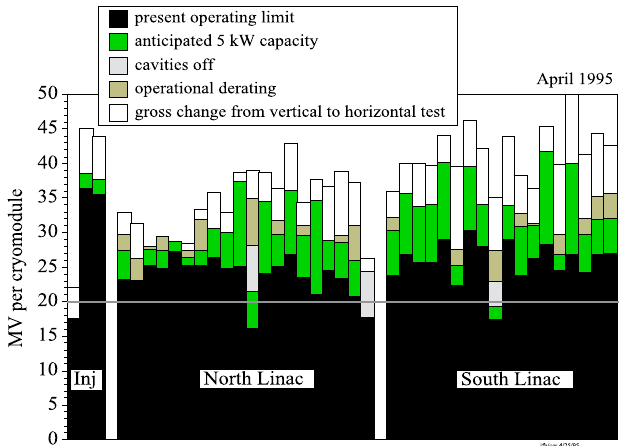
FIG. 9. Operational projection of CEBAF cryomodule capacity in 1995 (from